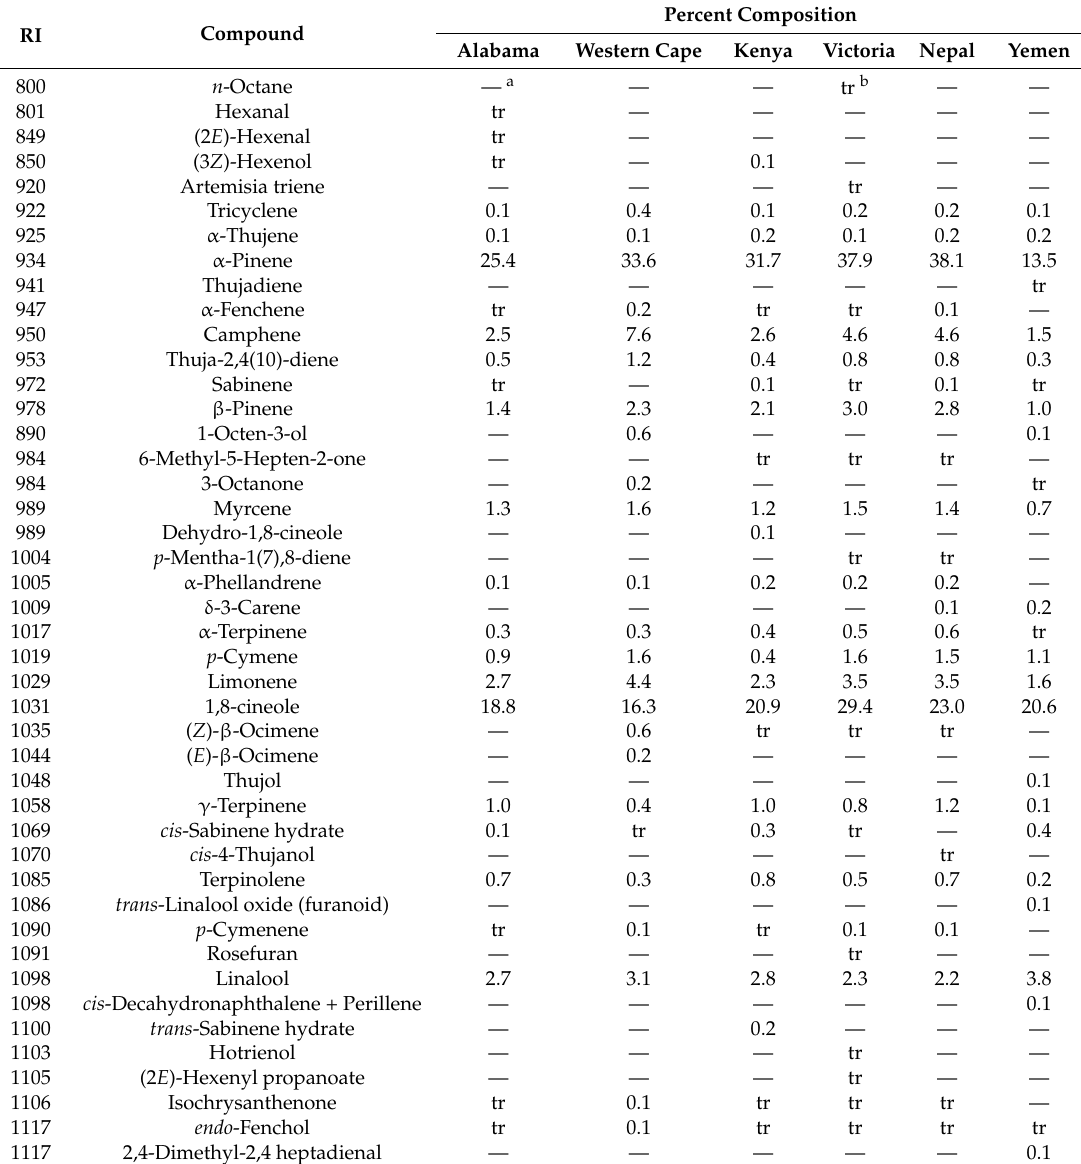
Table 1. Chemical compositions of essential oils of Rosmarinus officinalis from six different geographical